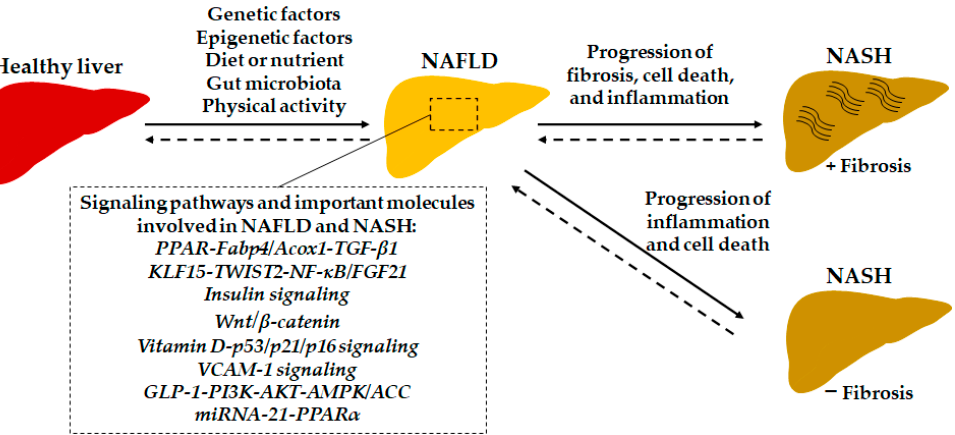
Figure 1. The important molecules and signaling pathways are involved in the development of NAFLD and the progression of NASH. Abbreviations: ACC , acetyl-CoA carboxylase; Acox1 , acyl-CoA oxidase 1; AKT , protein kinase B; AMPK , AMP-activated protein kinase; Fabp4 , fatty acid-binding protein 4; FGF21 , fibroblast growth factor 21; KLF15 , Krüppel-like factors 15; GLP-1 , glucagon-like peptide-1; NF- κ B , nuclear factor (NF)- κ B; PI3K , phosphoinositide 3-kinase; PPAR , peroxisome proliferator-activated receptor; TWIST2 , twist-related protein 2; VCAM-1 , vascular cell adhesion molecule 1.